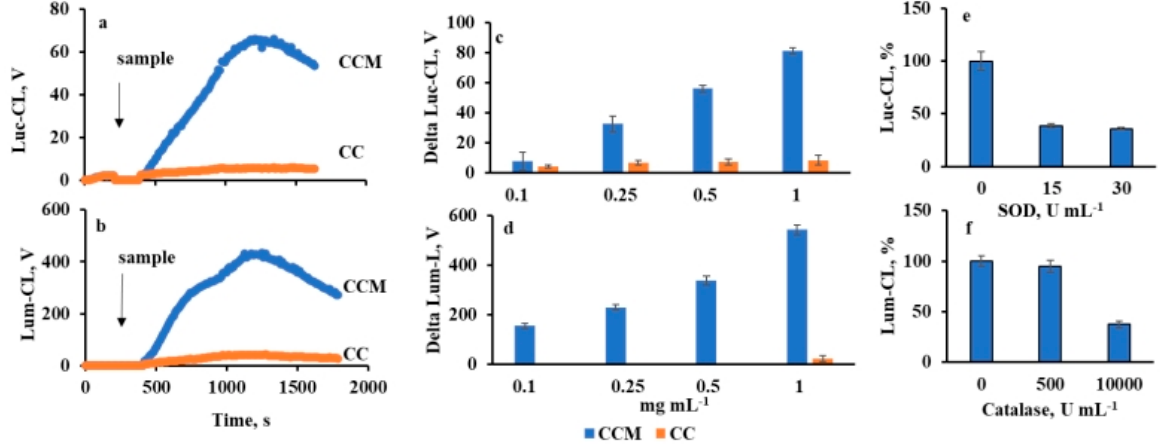
Figure 2. Neutrophil CL response activated by CC (in orange) and CCM (in blue): time-course of neutrophil Luc-CL ( a ) and Lum-CL ( b ) at particle concentration of 1 mg mL − 1 ; dose-dependence of CC and CCM effects on neutrophil Luc-CL ( c ) and Lum-CL ( d ) amplitude; effect of SOD on CCM- induced Luc-CL ( e ) and effect of catalase on Lum-CL ( f ) peak values (%). Neutrophil concentration was 0.6 × 10 6 cells mL − 1 . Each value was measured in triplicate.